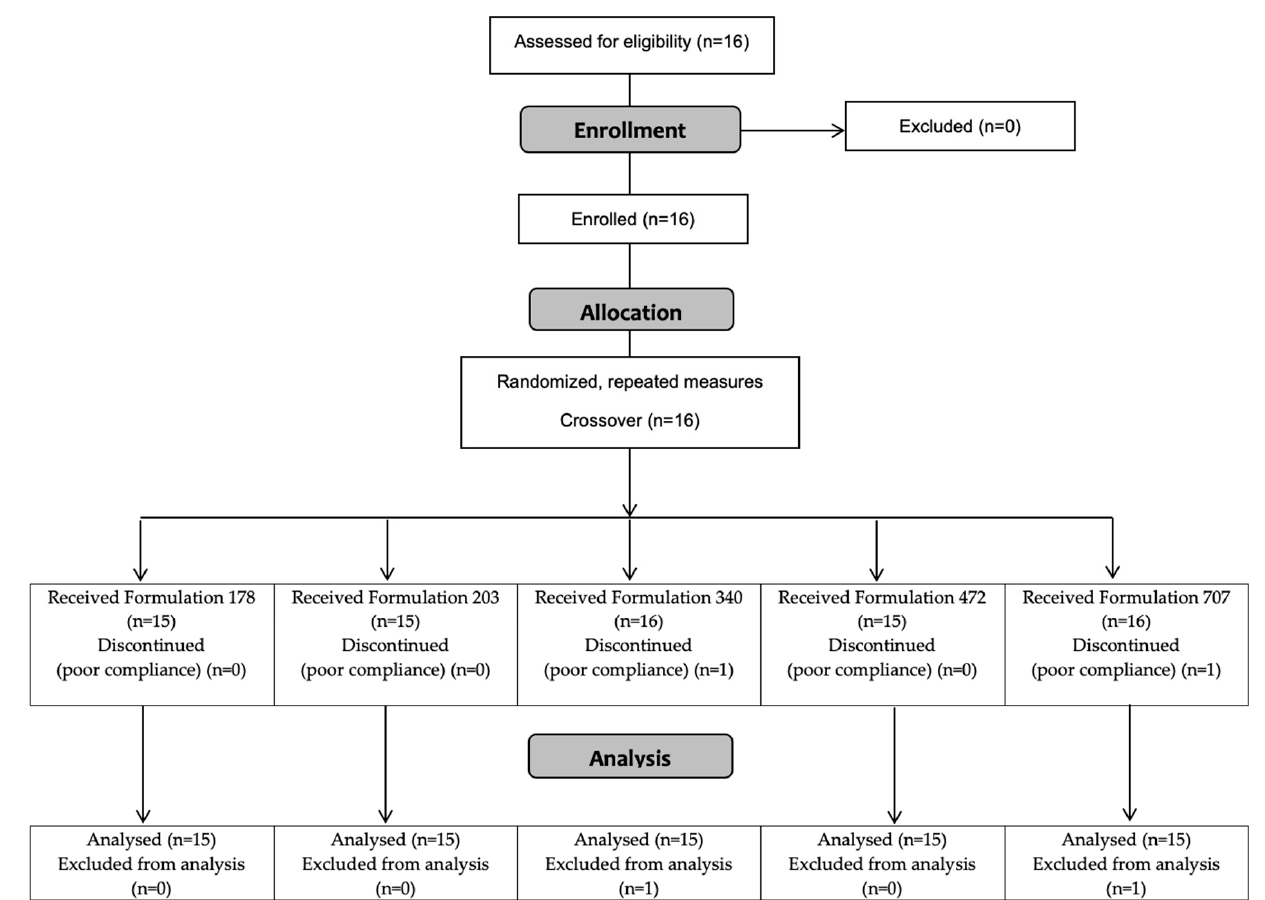
Figure 1. Consolidated Standards of Reporting Trials (CONSORT) flow diagram.